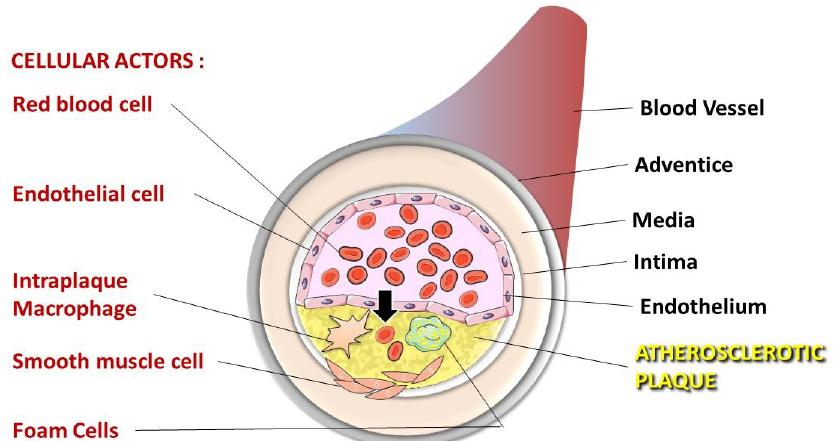
Figure 1. Cellular actors present in the atheroma plaque. Dysfunction of endothelial cells allows lipoprotein and erythrocyte infiltration in the sub-endothelial space (the arrow indicates this infiltration). Intraplaque macrophages that engulf oxidised LDL and infiltrated erythrocytes differentiate into foam cells initiating the atheroma formation. Enhanced inflammatory processes in atheroma cause smooth muscle cell migration from the media to the intima, towards the necrotic core formed by dead foam cells.